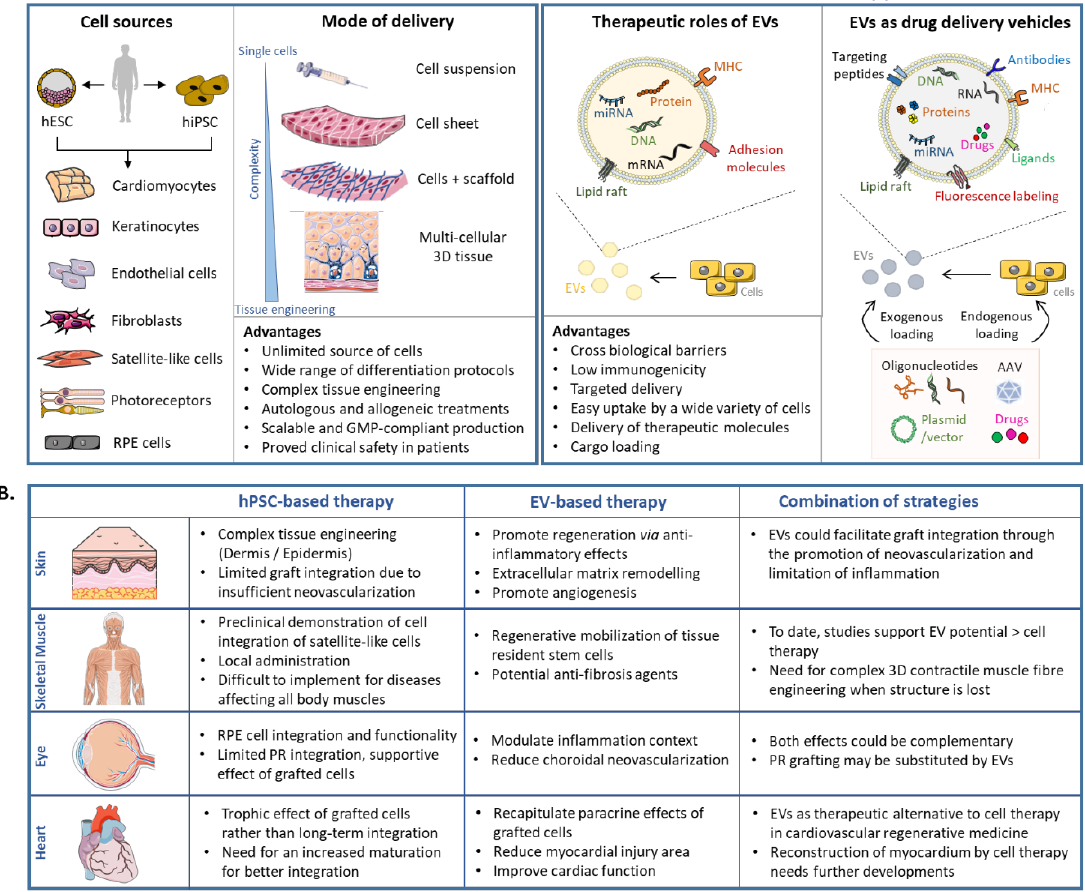
Figure 3. Disease-specific regenerative medicine strategy: toward tailored approaches. ( A ) Source material, mode of delivery and advantages of EV and hPSC-based therapies. ( B ) Therapeutic effects of EVs and cell therapies in preclinical animal models for selected organs (eye, skin, heart, skeletal muscle) and expected cumulative effects.